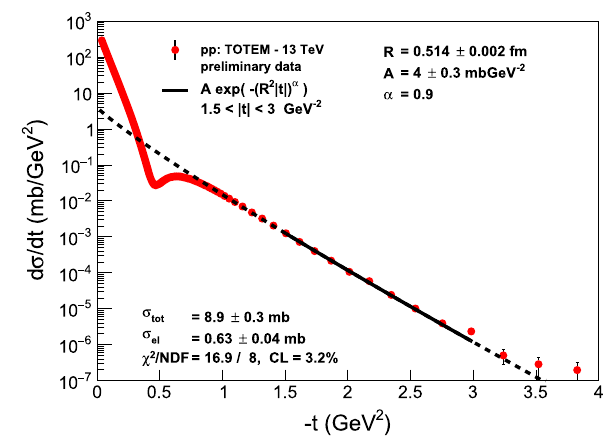
Fig. 33 Zeroth-order Lévy fits to the tail of the differential cross- section data on pp elastic scattering at fixed α = 0 . 9, A and R as free fit parameters